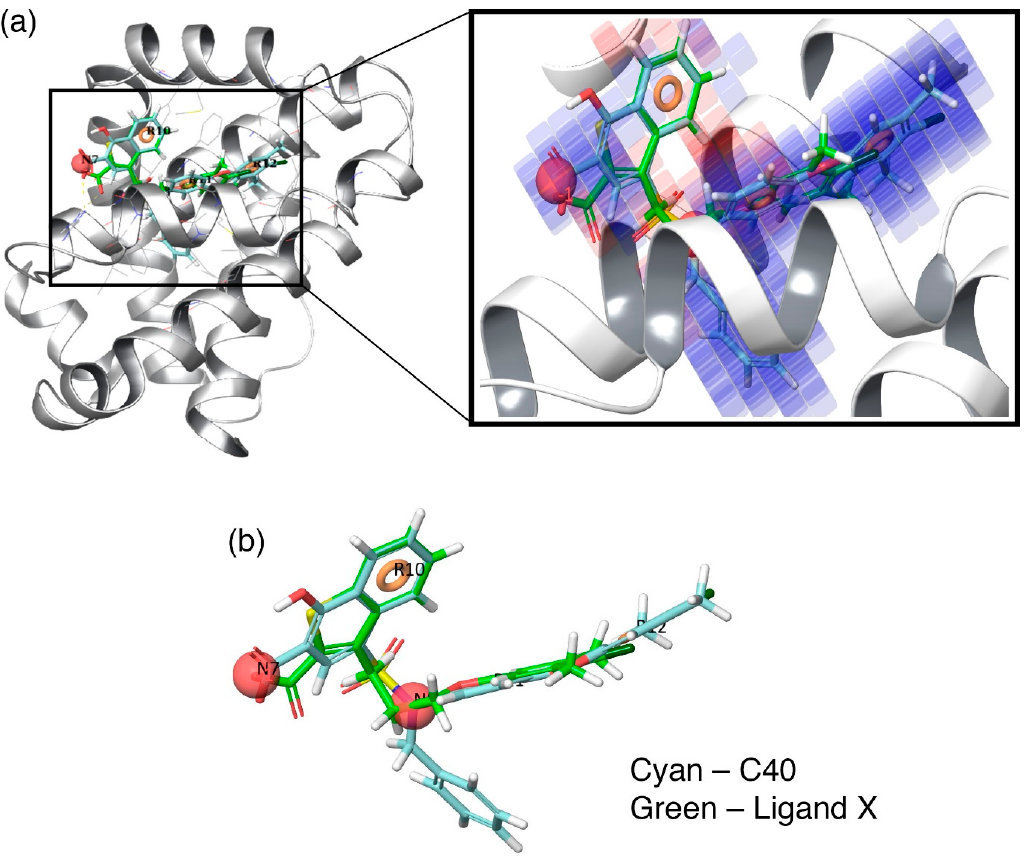
Figure 6. ( a ) Overlay of highly active inhibitor— C40 —together with its contour map onto the crystal structure of Mcl1 at the hydrophobic binding pocket and ( b ) alignment of the highly active inhibitor (cyan)— C40 —and its hypothesis over the crystal ligand X (green).